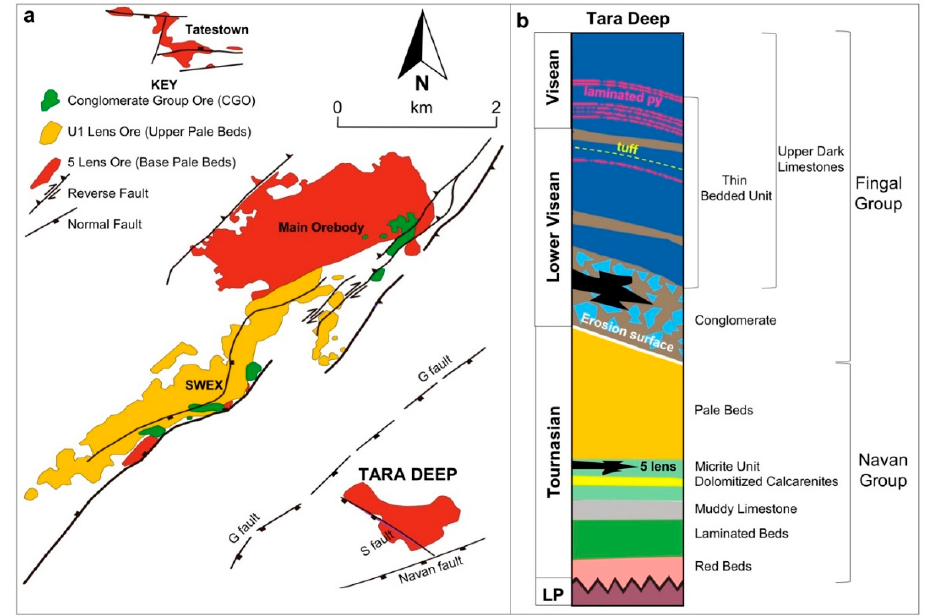
Figure 2. Geology of the Navan orebody including the Tara Deep deposit ( a ) Map projection of the top surface of the Navan system, including the different deposits and main structural features (modified from Ashton et al. [11]); ( b ) Stratigraphic column of the Tara Deep area showing the different ore lenses and hosting rocks. (L.P. = Lower Palaeozoic).